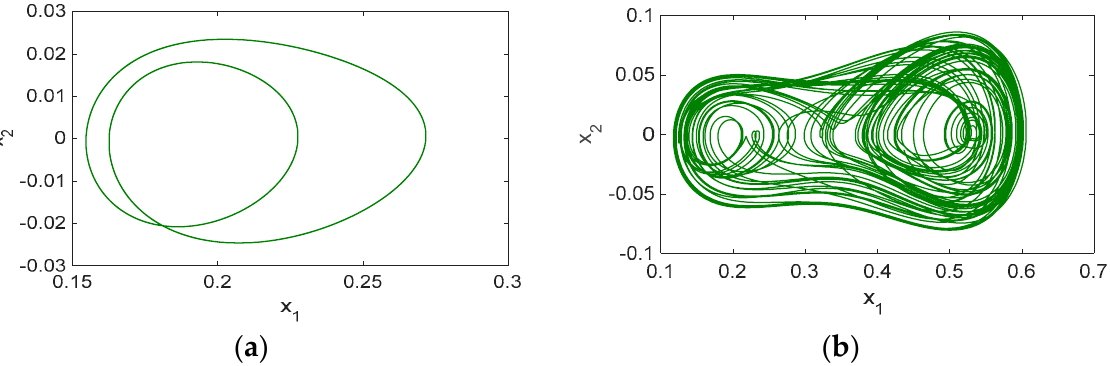
Figure 2. Phase portrait of MEMS resonator when α 1 ( t ) = α 2 ( t ) = 0.98 generated with initial conditions ( 0,0 ) when ( a ) R = 0.01, ( b ) R =